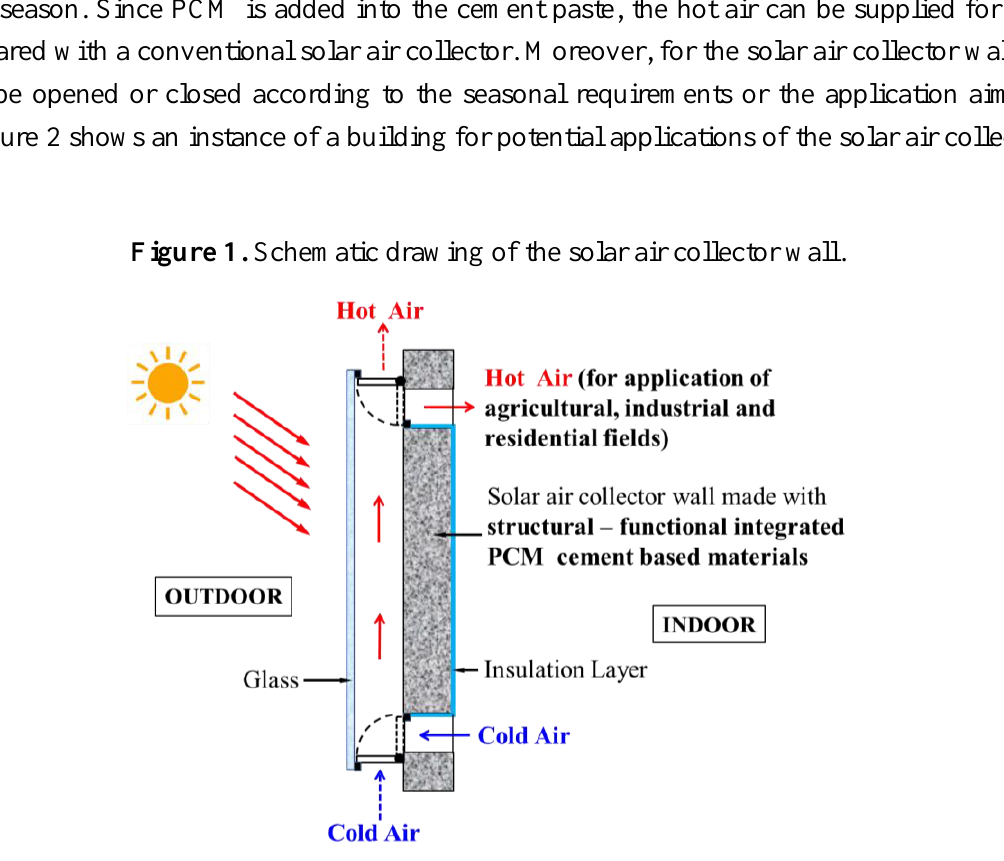
Figure 2. Schematic drawing of an instance of a building for applications of the solar air collector wall and